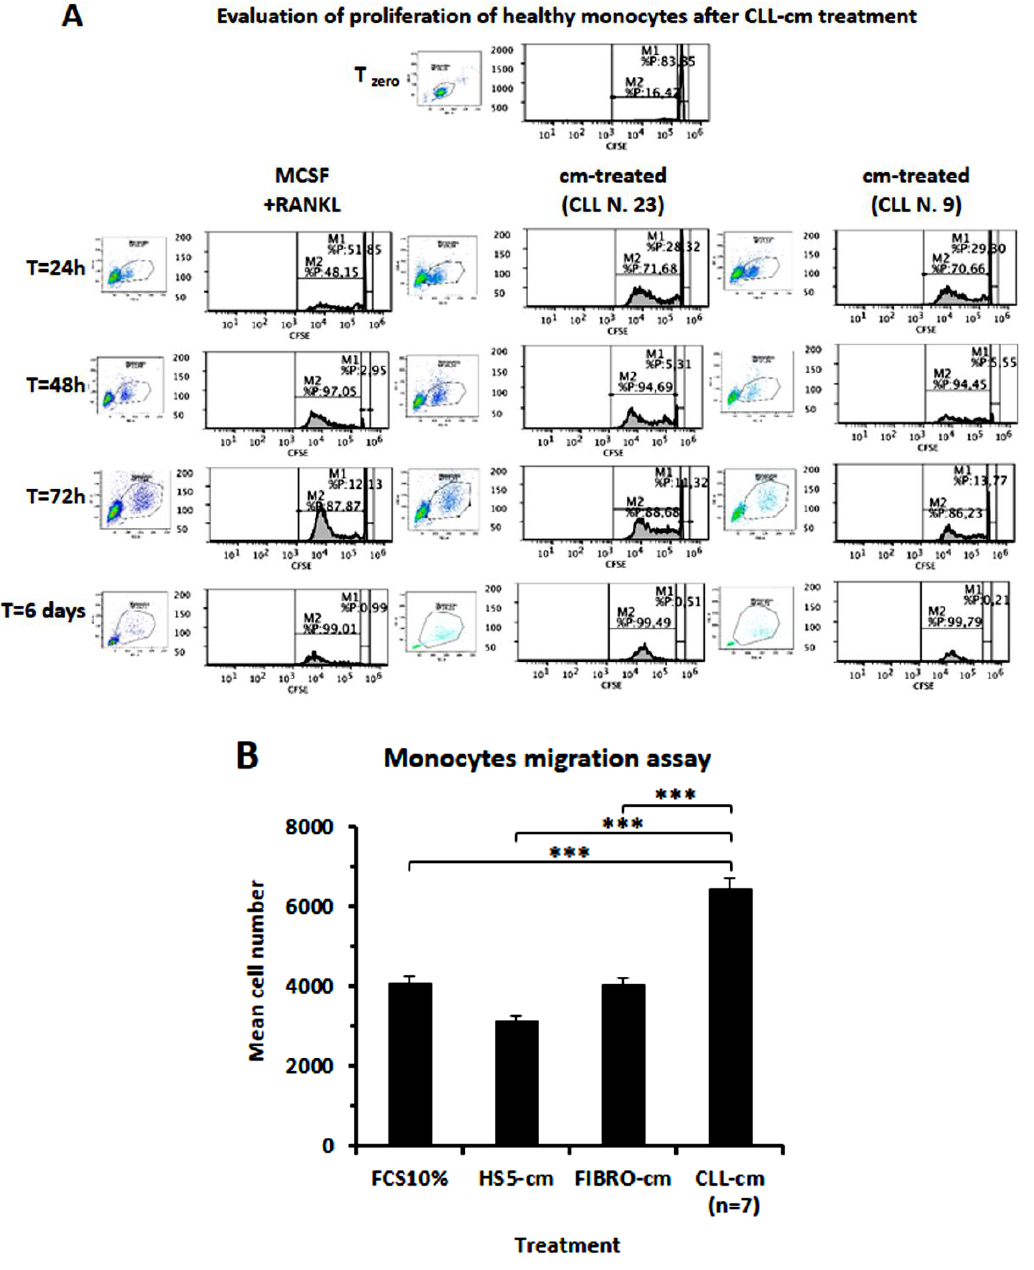
Figure 9. Evaluation of proliferation and migration of healthy monocytes in response to MCSF+RANKL and to CLL-cm treatments. ( A ) CLL-cm treatments stimulated monocytes to grad- ually divide and proliferate, as evaluated by CFSE staining. CFSE staining at time 0 was evaluated on the total gated population of purified monocytes. In the remaining experimental time course (24 h – 6 days) only activated and large monocytes were gated and evaluated to better address mitotic peaks. Results from two representative cases (Cases N. 23 and N. 9) are here depicted. ( B ) CLL-cm treatment further induced a strong and significant migration of healthy monocytes as compared with conditioned medium derived from a stromal (HS5) or a fibroblastic (Fibrogem) cell line or with medium alone (FCS10%). Bars are representative of the mean ± SD of two separate experiments. Statistical significance was determined by using ANOVA and Tukey’s post hoc test. 3.7. Increased Osteo-Clastogenesis by M2-Polarized Monocytes We next investigated whether monocyte polarization could enhance CD16 expres- sion and, in parallel, affect osteoclast differentiation. As shown in Figure 10A, monocytes polarized toward the M2 phenotype exhibit higher CD16 expression. Moreover, when healthy monocytes were pre-treated with conditioned media derived from the cultures of the THP-1 monocytic cell line previously polarized toward M1 (LPS+ IFN γ ), M2a (IL4) or M2c (IL10), before the addition of MCSF and RANKL, we could observe a more consistent number of osteoclasts for monocytes pre-treated with conditioned media derived from THP1-M2, particularly for THP-1-M2c (Figure 10B,F). In agreement, we observed a larger area of bone resorption (Figure 10C,F). The direct pre-treatment of purified monocytes with PMA+ IL10, to induce M2c polarization, also gave rise to a higher number of osteo- clasts (Figure 10D,G) that produced significantly larger areas of bone erosion (Figure 10E,G ).